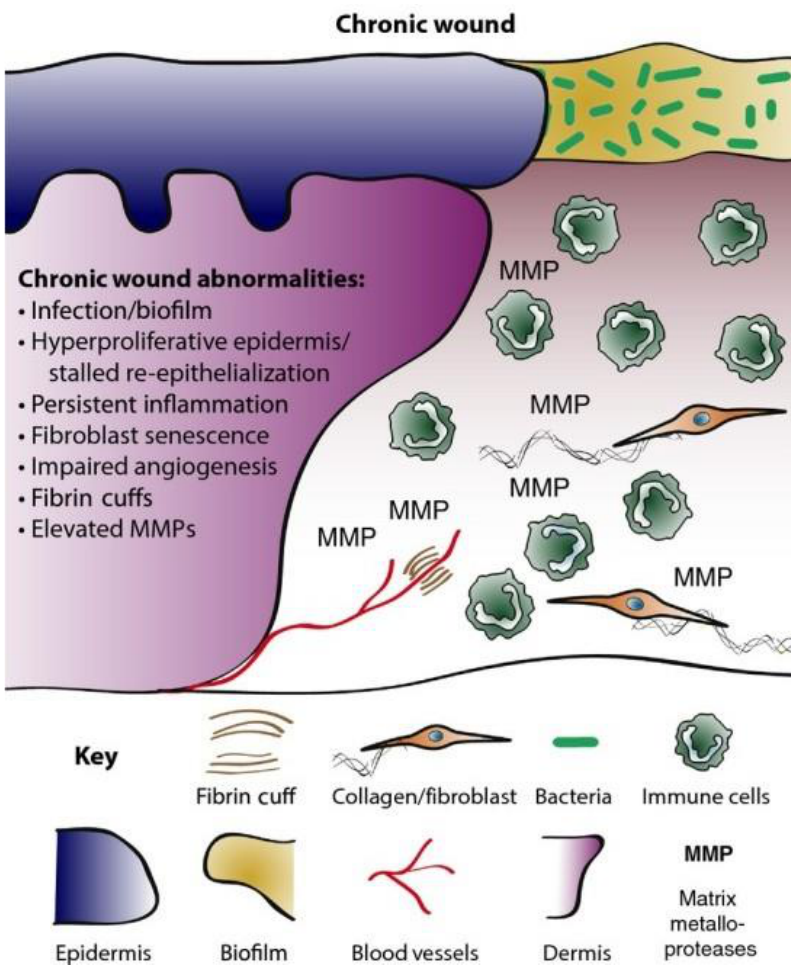
Figure 2. Biology of chronic wounds as shown by Martin and Nunan [2]. CWs are usually influenced by microbial infections resulting in persistent inflammation due to the recruitment of highly inflammatory infiltrates and inhibition of tissue regeneration [2].